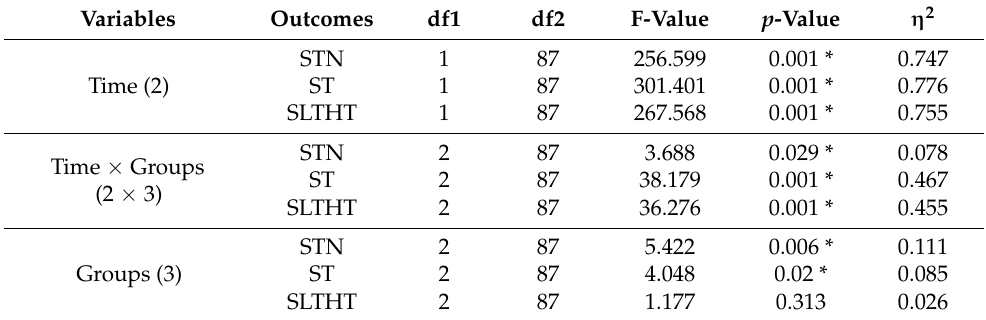
Table 2. The main effect of treatment on the outcomes, within-subject factors across the time (pre- and post-), between-subject factors between the groups (RST vs. PT vs. Control), and the interaction between groups (3) and time (2) using a mixed design 3 × 2 ANOVA